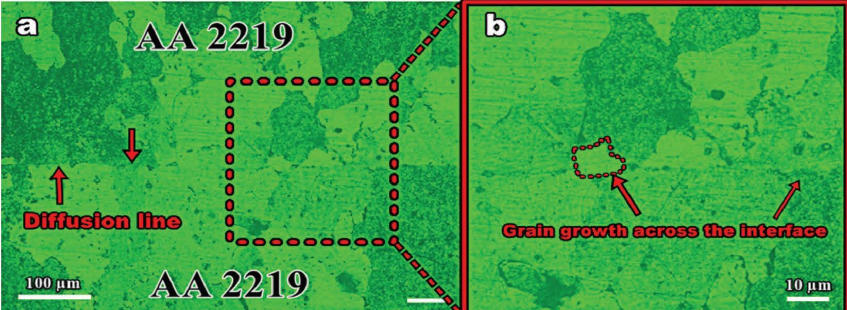
Figure 5: (a) Optical micrographs of the section bonded at 475 ° C and (b) enlarged view of the rectangular drawn in (a).